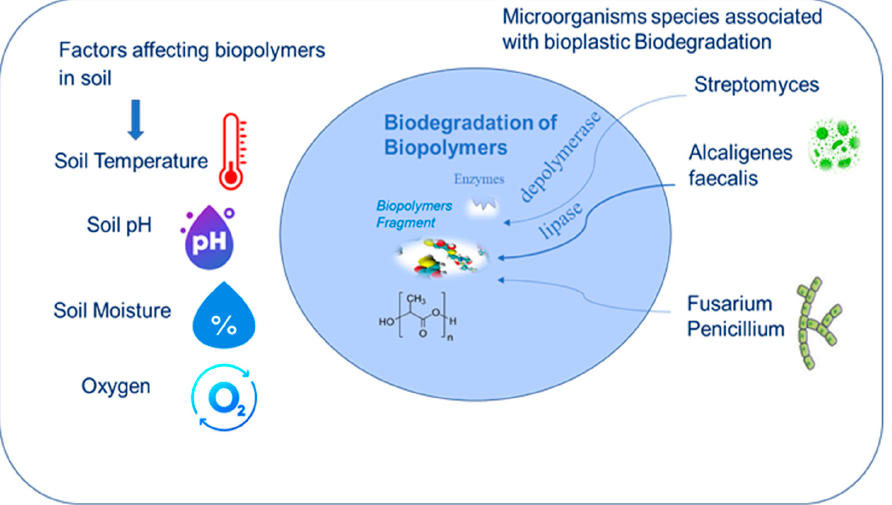
Figure 1. Interactions of microbes and environmental factors in microplastic-contaminated soils.